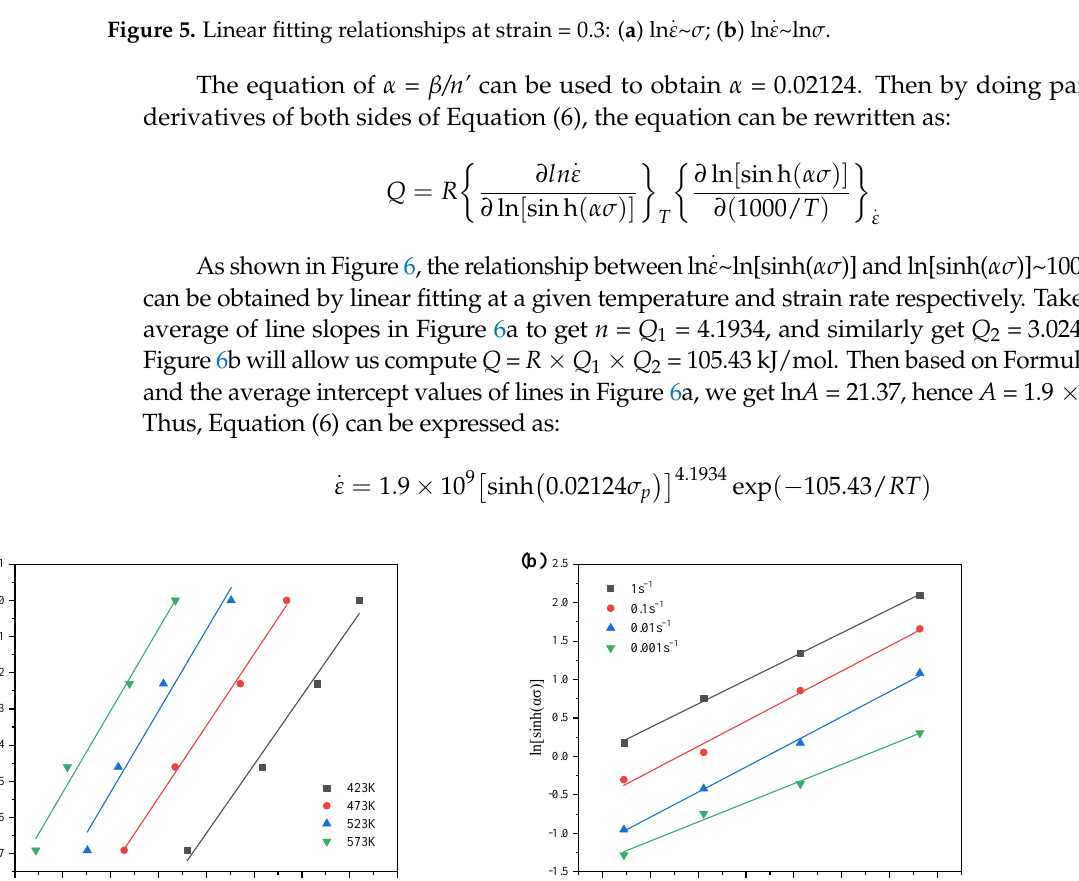
Figure 6. Linear fitting relationships at strain = 0.3: ( a ) ln[sinh( ασ )]~ln